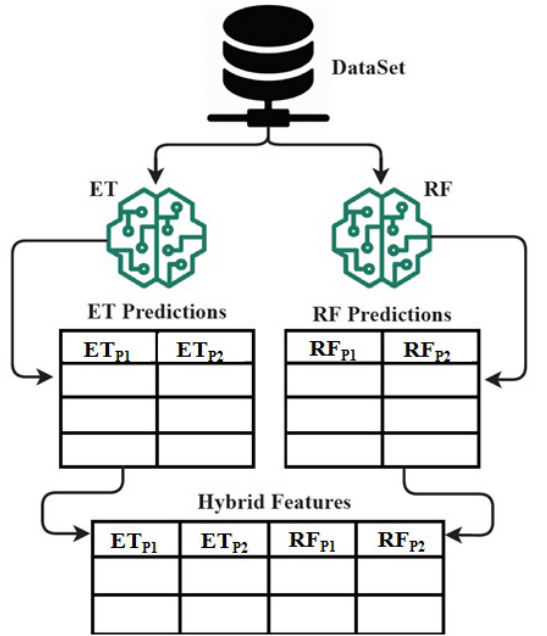
Figure 9. The architecture analysis of proposed ETRF technique for hybrid feature set formation